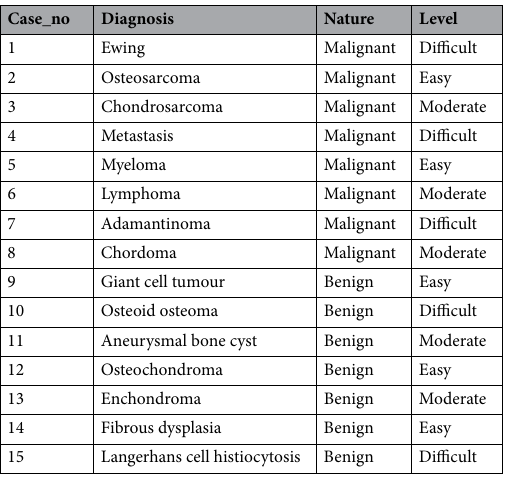
Table 1. Estimated probabilities of correct diagnoses along the sequence of